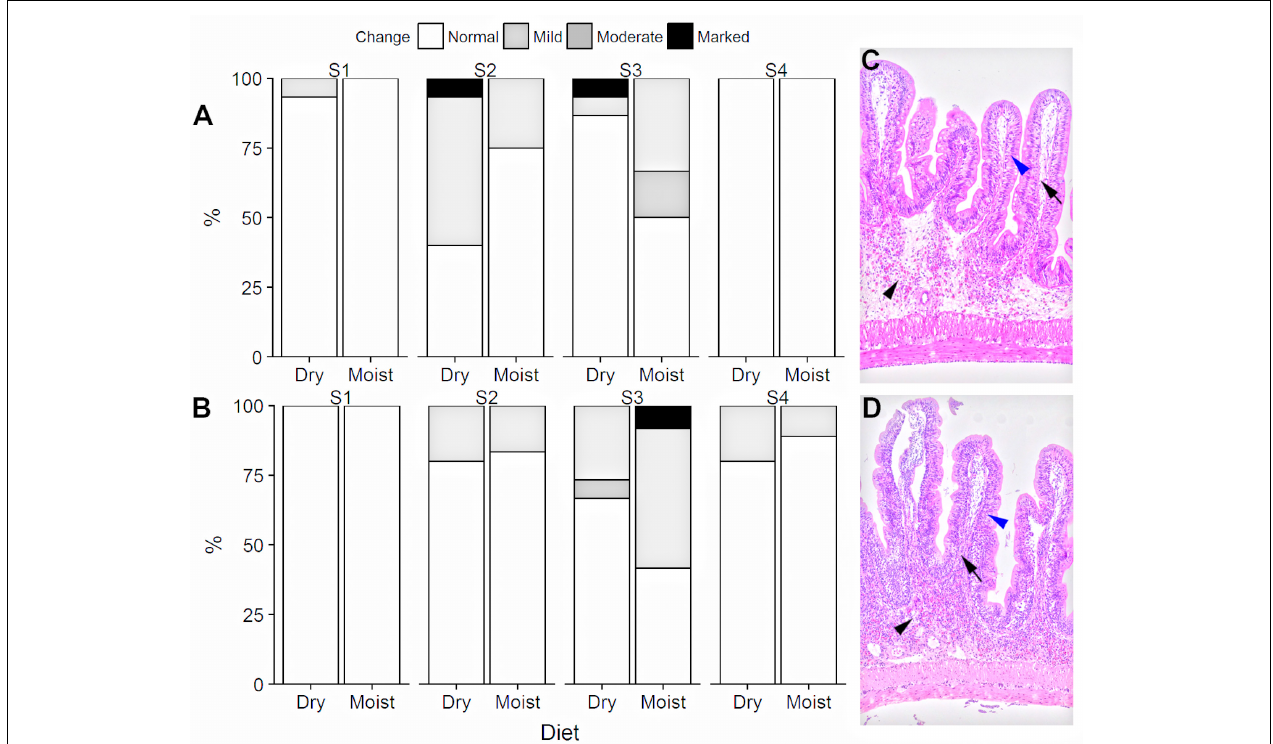
FIGURE 2 | Histological evaluation of intestinal segments in ballan wrasse fed either dry or moist diets. The percentage of each intestinal segment that had normal, mild, moderate, or marked infiltration of mixed populations of inflammatory cells in the intestinal lamina propria (A) and intraepithelial lymphocyte infiltration (B) . S1, S2, S3, S4 stand for Segments 1, 2, 3, 4. Data were obtained from 15 fish each for all segments for the dry diet, 12 each (S1–S3) and 9 each (S4) fish for the moist diet. (C) Normal. (D) Moderate submucosa (black arrowhead) and lamina propria (black arrow) increase in cellularity due to infiltration by a mixed population of inflammatory cells and infiltration of the intraepithelial space (blue arrowheads). There was no statistical difference between moist and dry diets (Fisher’s Exact test, p >